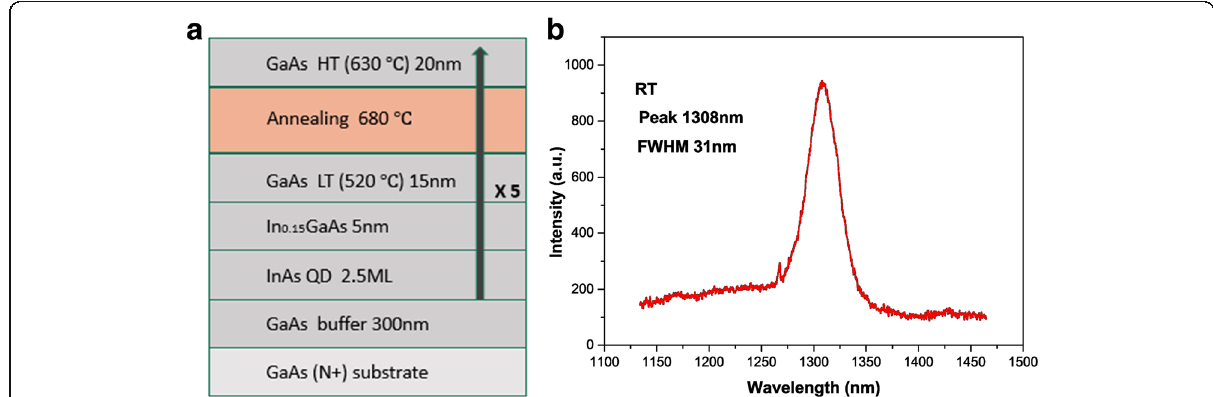
Fig. 2 The active region structure and PL spectrum. a The structure of the undoped QD laser active region. b PL spectrum of the QD laser active region at room temperature (RT). The emission peak is 1305 nm and the FWHM is about 31